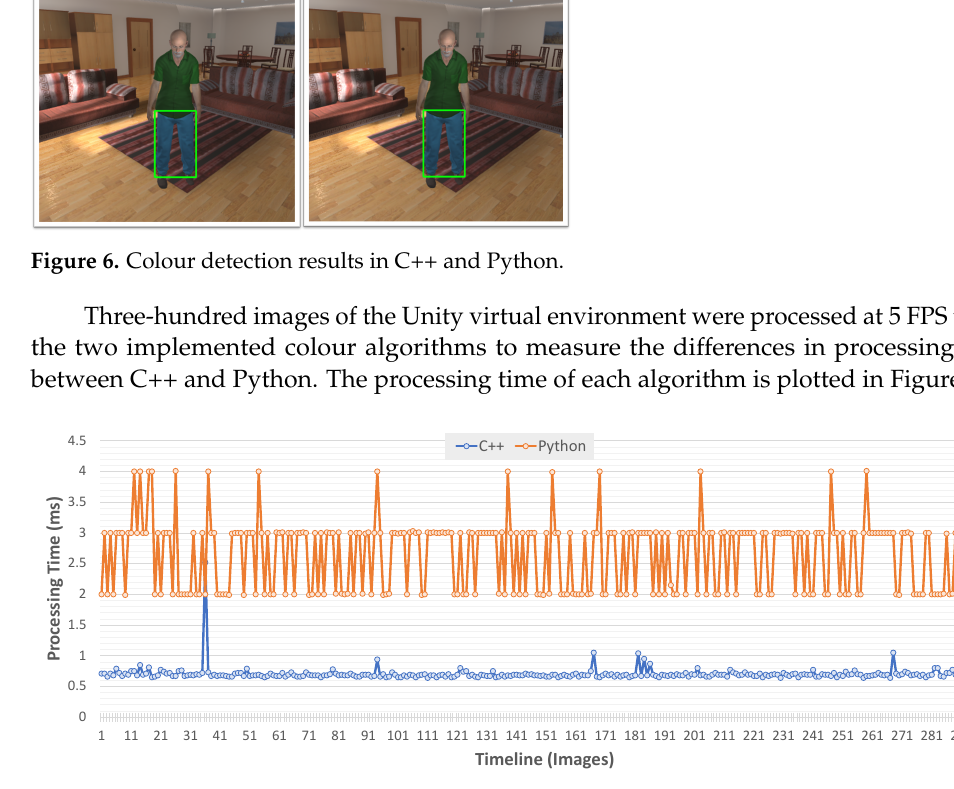
Figure 7. Processing times of the colour detection algorithm in C++ and Python. For C++ DLL: average, 0.70 ms; minimum, 0.64 ms; maximum, 2.52 ms. For Python MQTT: average, 2.65 ms; minimum, 1.98 ms; maximum, 4.0 ms.